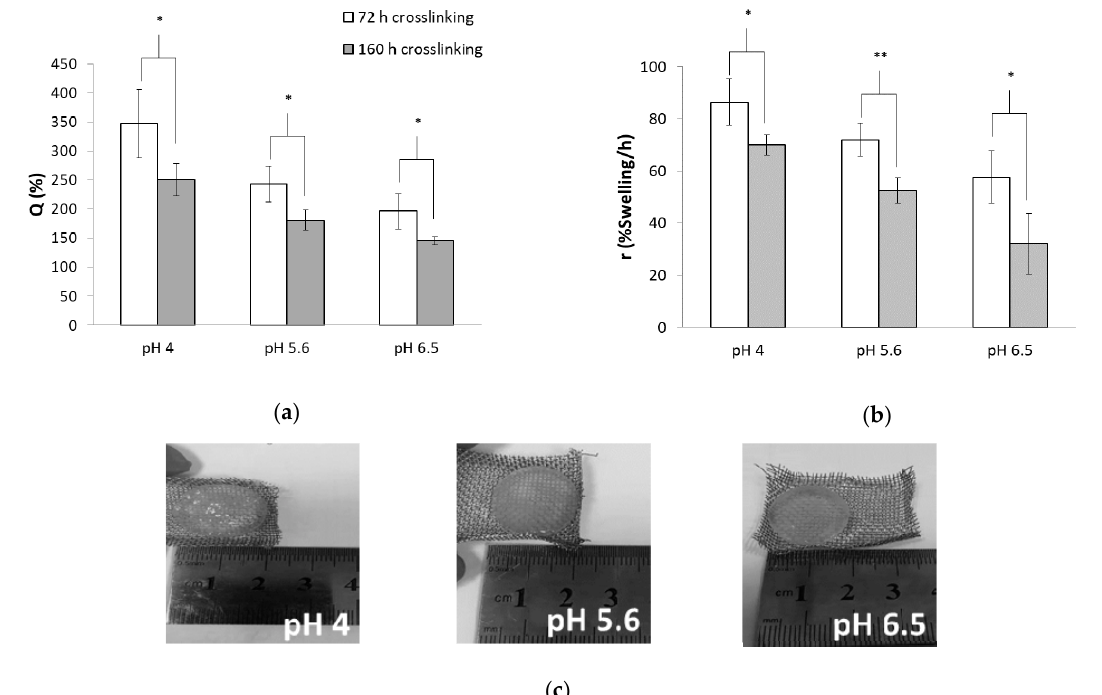
Figure 6. ( a ) Q-Swelling in equilibrium and ( b ) initial water gain rate vs. pH value during preparation. ( c ) Swollen hydrogels cross-linked for 160 h. The bars represent the standard error of the mean, n = 4. (*) refers to a statistically significant difference of p < 0.05, and (**) refers to a statistically significant difference of p < 0.01.